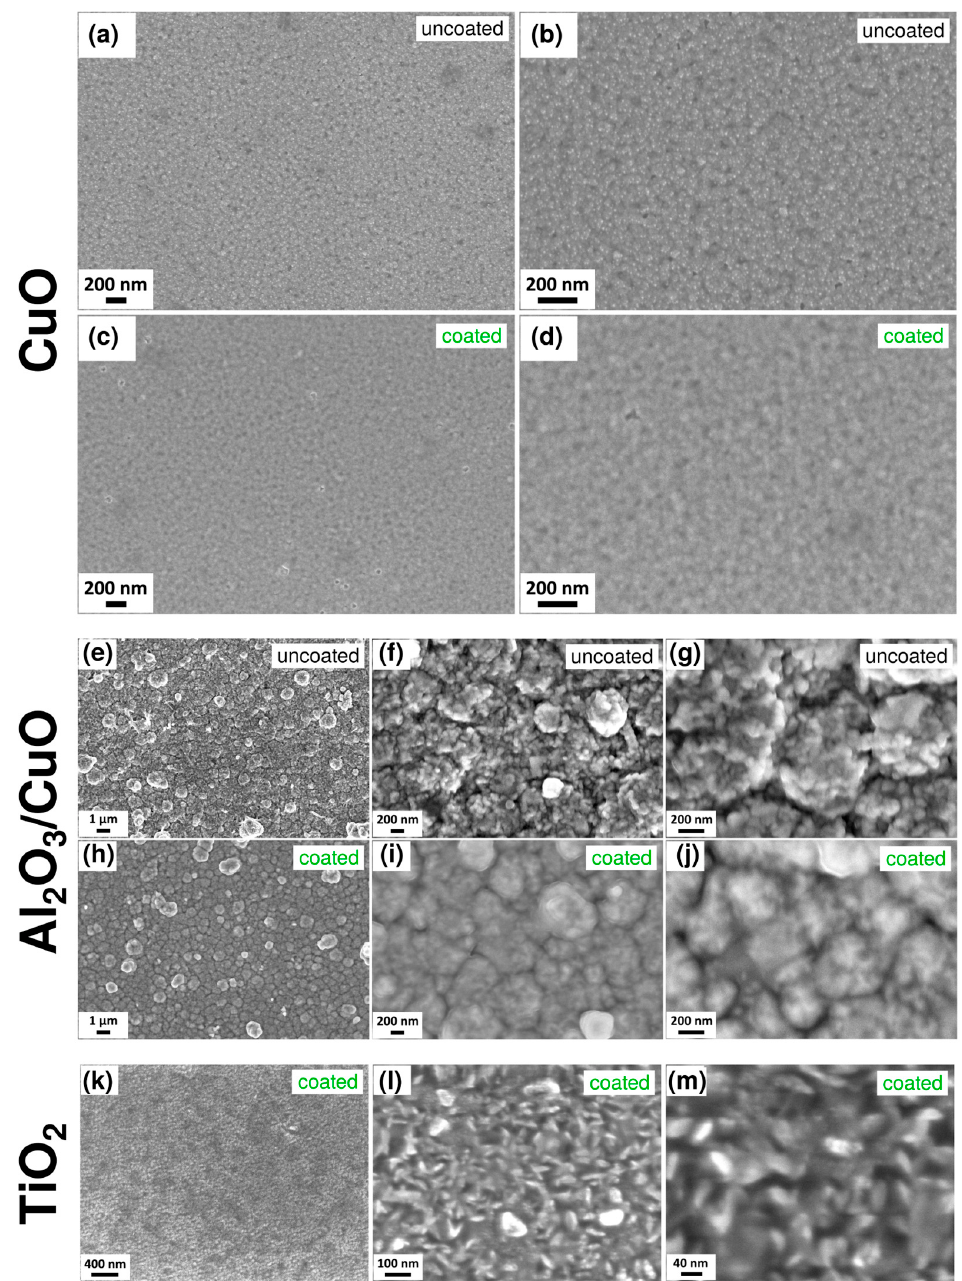
Figure 2. SEM images of the morphologies of the three different gas sensor structures investigated in this study. Uncoated CuO structure grown by sputtering at: ( a ) low magnification and ( b ) high magnification. SEM images of the CuO structure grown by sputtering then covered with PV4D4 thin film at ( c ) low magnification and ( d ) high magnification. Uncoated Al 2 O 3 /CuO obtained by ALD/SCS approaches and measured at magnification ( e ) 1 µm; ( f ) and ( g ) 200 nm scale bar. SEM images of the Al 2 O 3 /CuO by ALD/SCS covered on top with PV4D4 thin film at ( h ) 1 µm; ( i ) and ( j ) 200 nm scale bar. TiO 2 structures with a thickness of 30 nm and a 25 nm PV4D4 thin film on top measured at ( k ) low magnification; ( l ) medium magnification; and ( m ) high magnification by SEM.